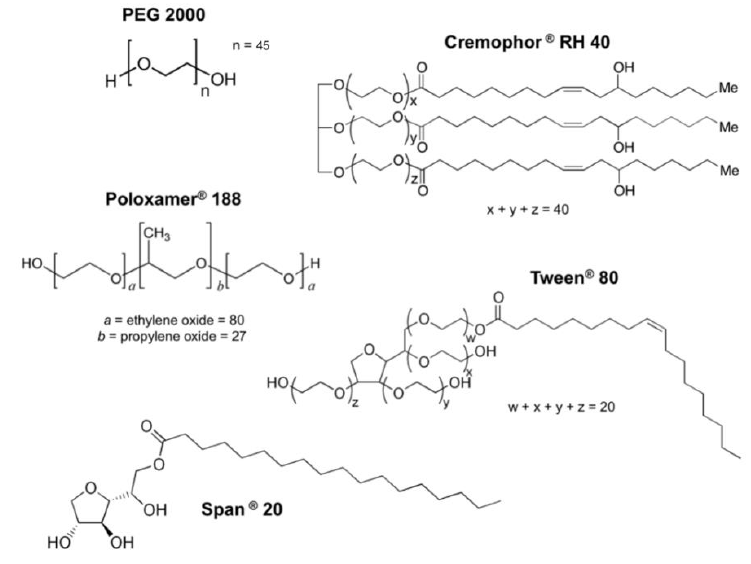
Figure 1. Chemical structures of tested excipients.